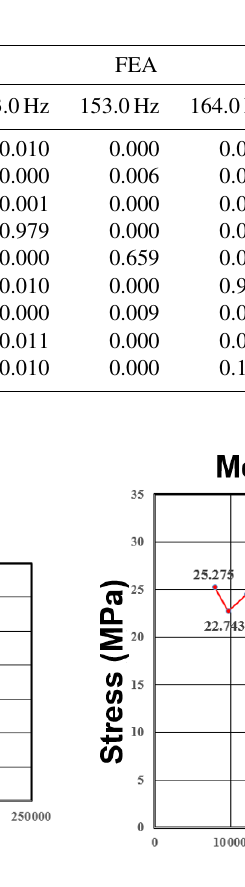
Table 10. The verification results of modal assurance criterion (MAC) for the mode shapes obtained from the experimental modal analysis (EMA) and finite element analysis (FEA) of the frame.